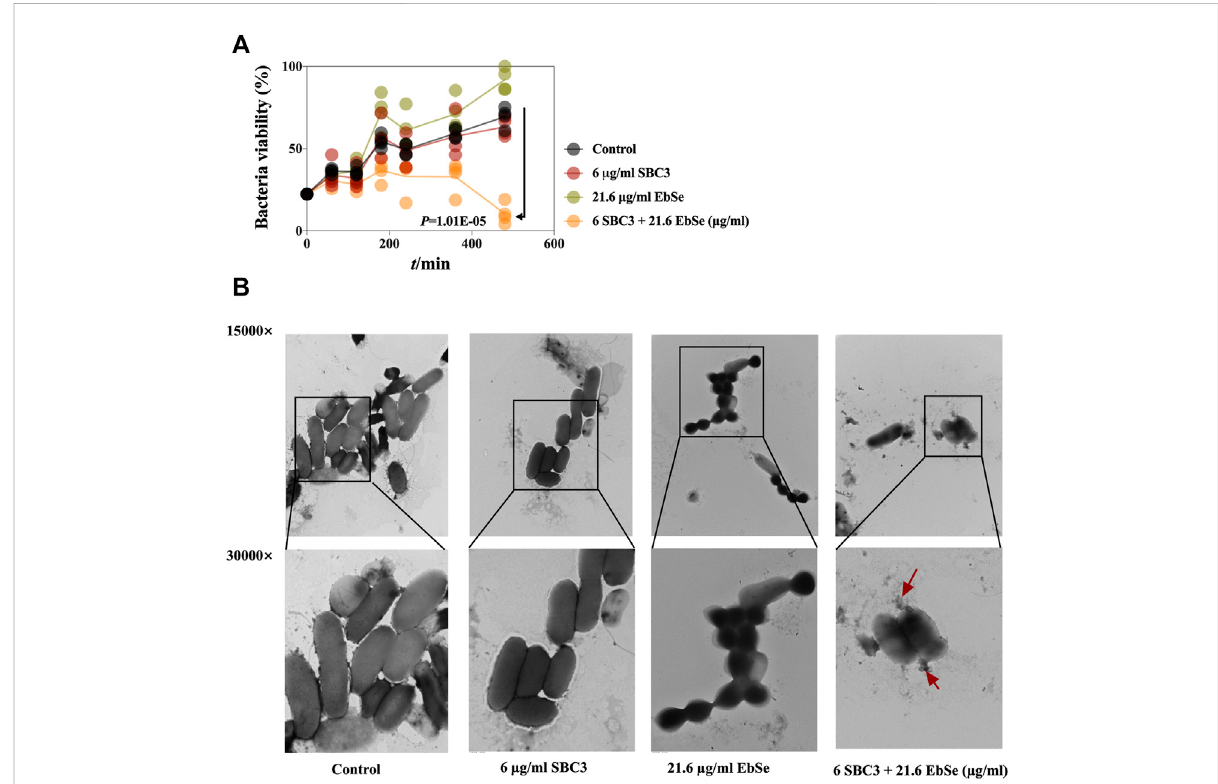
Antibacterial effect of Ebselen and SBC3 on E. coli DHB4. E. coli DHB4 was cultured until an A 600 = 0.4 and treated for 30 min with SBC3 and Ebselen. (A) Cell viability was represented by measuring A 600 . The growth curves showed a synergistic antibacterial effect of SBC3 and Ebselen